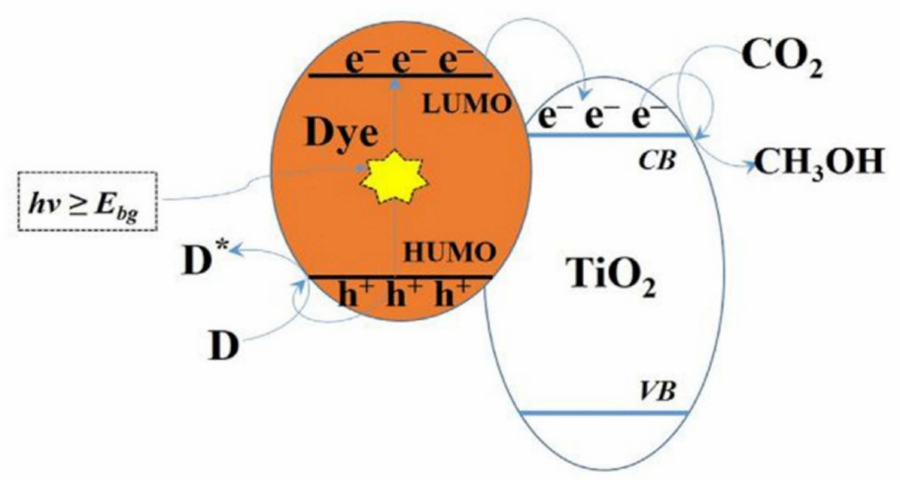
Figure 22. Photoreduction scheme of CO 2 to methanol using dye-sensitized TiO 2 photocatalyst. Reprinted with permission from Elsevier, 19 December 2021 Ref.